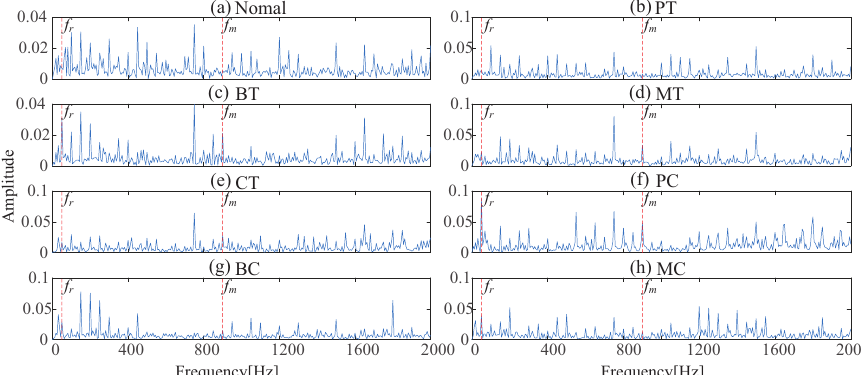
Figure 10. The vibration signals for eight gear-health conditions: ( a ) healthy condition ( b ) pitting in the driving tooth ( c ) a broken tooth in the driving gear ( d ) a missing tooth in the driving gear ( e ) crack in the follower tooth ( f ) pitting in the driving gear with crack in the follower tooth ( g ) broken tooth in the driving gear with crack in the follower tooth ( h ) missing tooth in the driving tooth with crack in the follower tooth.